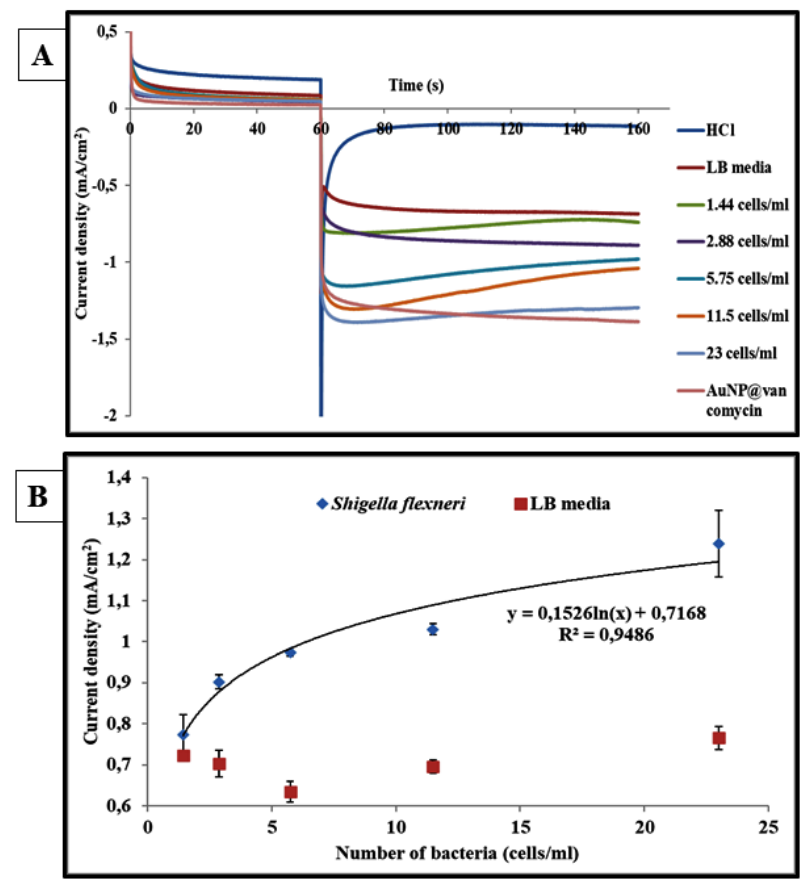
Figure 6. Chronoamperometric curves correspond to the response of the centri-chronoamperometric assay without bacteria (noninoculated LB media) and with various S. flexneri concentrations: 1.44, 2.88, 5.75, 11.5, and 23 cells/mL ( A ). Biosensor response to various concentration of S. flexneri . The curve indicates the fitting of the experimental data with a logarithmic regression (current density) = 0.1526 × ln ( S. flexneri concentration) + 0.7168 (R2 = 0.9486) ( B ). Current density = 0.1526 ln ( S. flexneri concentration) + 0.7041, with a correlation coefficient R 2 =